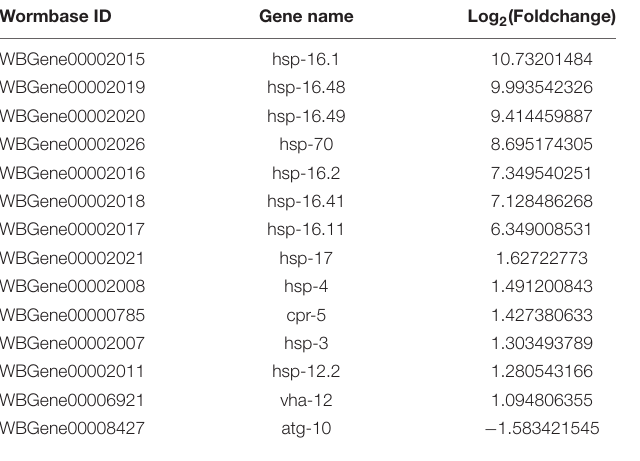
TABLE 3 | Autophagy-related gene expression after 8 h A β induction.